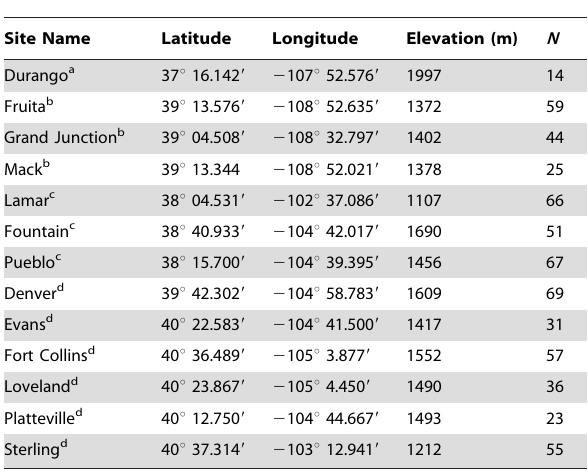
Table 1. Site information for specimens in this study. Site Name